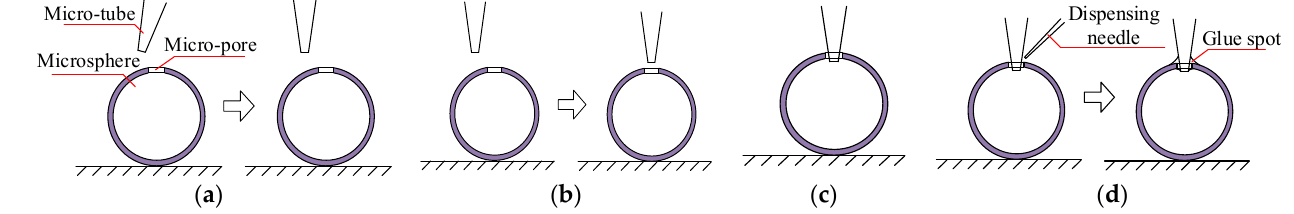
Figure 1. Diagram of assembly process: ( a ) attitude alignment; ( b ) position alignment; ( c ) insertion depth control; ( d ) dispensing process.